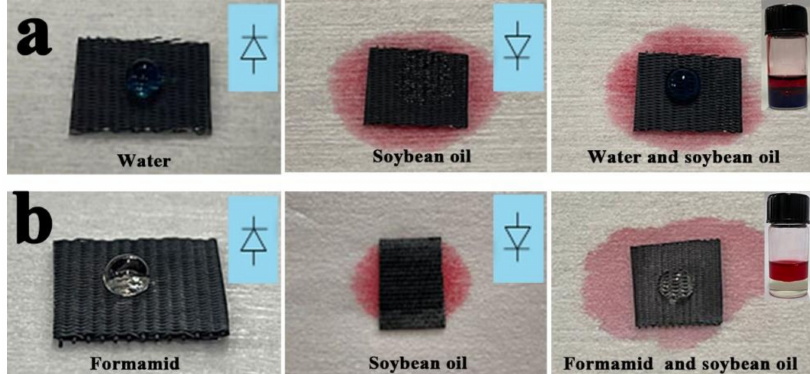
Figure 5. Photographs of oil/water ( a ) and oil/oil separations ( b